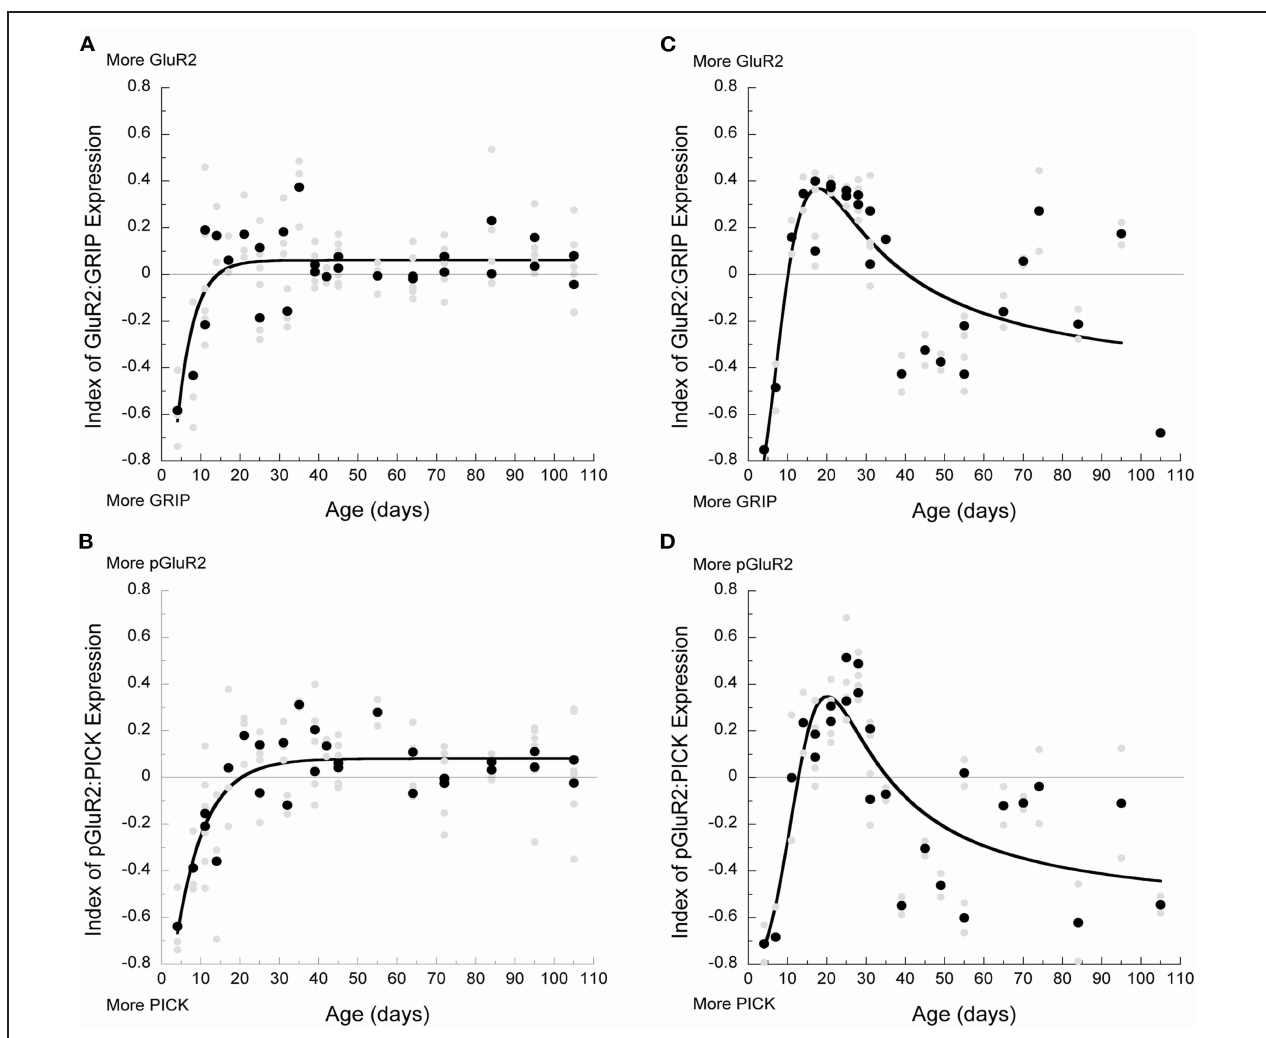
FIGURE 5 | Development of surface and internalized components in visual and frontal cortex. (A) Index of GluA2:GRIP during development in visual cortex showed that initially more GRIP was present, but by P13, a balance with slightly more GluA2 was reached (3 τ , R 2 = 0 . 62, p < 0 . 0001). (B) Index of pGluA2:PICK1 in visual cortex showed that more PICK1 was present early in development, but a balance was reached by P22 (3 τ , R 2 = 0 . 69, p < 0 . 0001). (C) In frontal